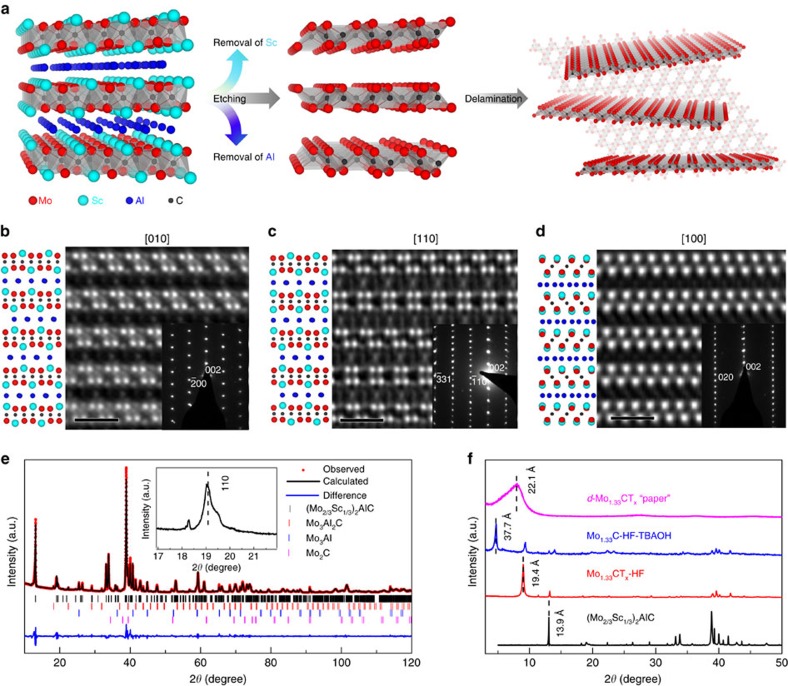
In-plane chemical ordering of (Mo2/3Sc1/3)2AlC leading to Mo1.33C MXene with ordered divacancies.(a) Schematic of (Mo2/3Sc1/3)2AlC before etching (left panel), after etching (middle panel) and after delamination (right panel). Background in the right panel shows the plane view of Mo1.33C MXene with ordered divacancies. (b–d) In-plane chemical ordering of the MAX phase evident from STEM images along the [010], [110] and [100] zone axis, respectively, with corresponding selected area electron diffraction (SAED). Schematics to the left of each image represent the corresponding atomic arrangements assuming the structure is the monoclinic space group C2/c (15). (e) Rietveld refinement of XRD of sample with nominal composition (Mo2/3Sc1/3)2AlC assuming same space group as above. (f) XRD pattern of (Mo2/3Sc1/3)2AlC before (black), after HF etching (red), and TBAOH intercalation (blue) and delamination (purple). Scale bars in (b–d) correspond to 1 nm.